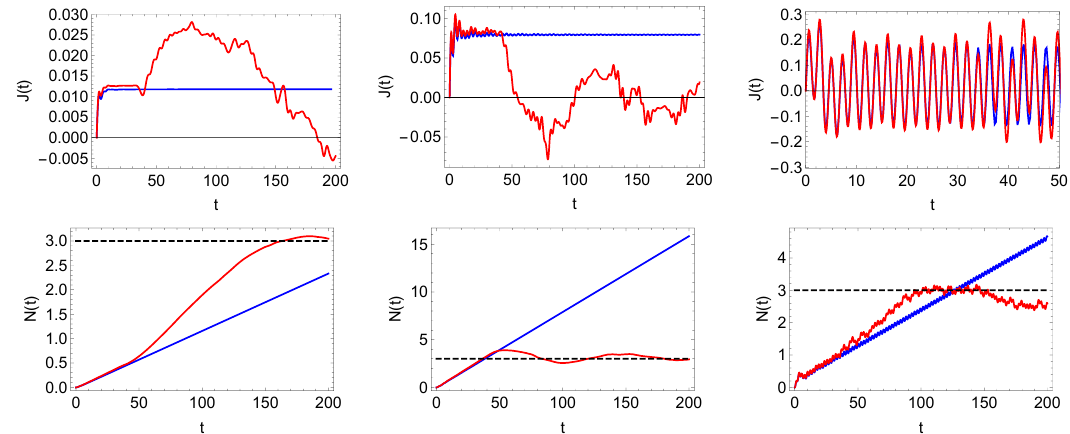
Figure 3: The current through the link (upper panels) and the number of particles in the right chain (lower panels) for (cid:34) = 0.3 (left), (cid:34) = 1.0 (center) and (cid:34) = 2.4 (right). Red curves correspond to numerical results for the initially partially filled left chain ( N = 6 fermions, 18 sites in the left chain). The current (86) in the thermodynamic limit is shown by blue solid lines. The black dashed lines in lower panels indicate the half of the initial number of particles. Notice the change of the time scale in the upper left